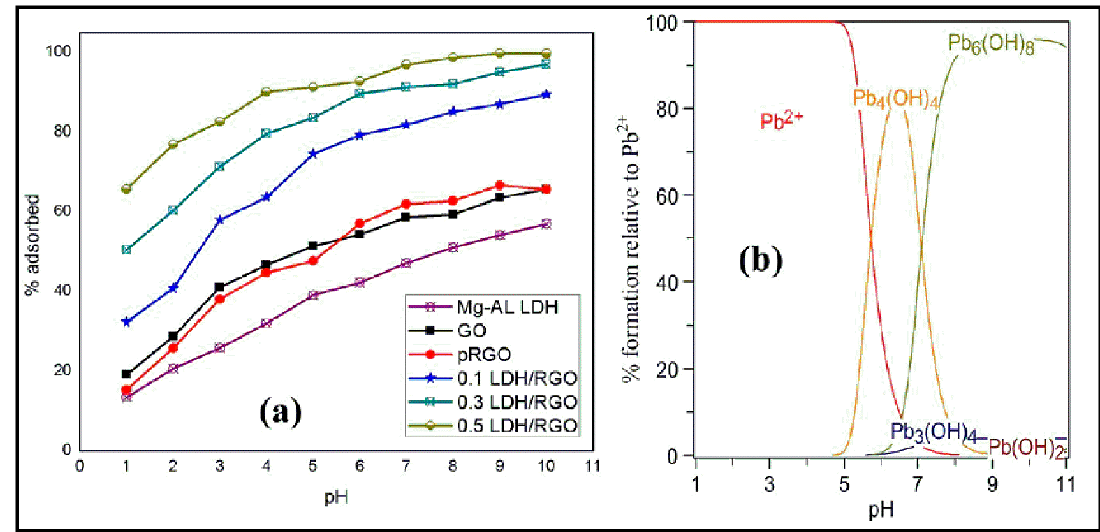
Figure 2. ( a ) Adsorption e ffi ciency of LDH, GO, pRGO, and x Mg − Al LDH / pRGO adsorbents at pH 1 Figure 2. (a) Adsorption efficiency of LDH, GO, pRGO, and 𝑥 Mg − Al LDH/pRGO adsorbents at pH 226 to 10. ( b ) Speciation of Pb(II) as a function of pH 1 to 10. (b) Speciation of Pb(II) as a function of pH [174] . 227